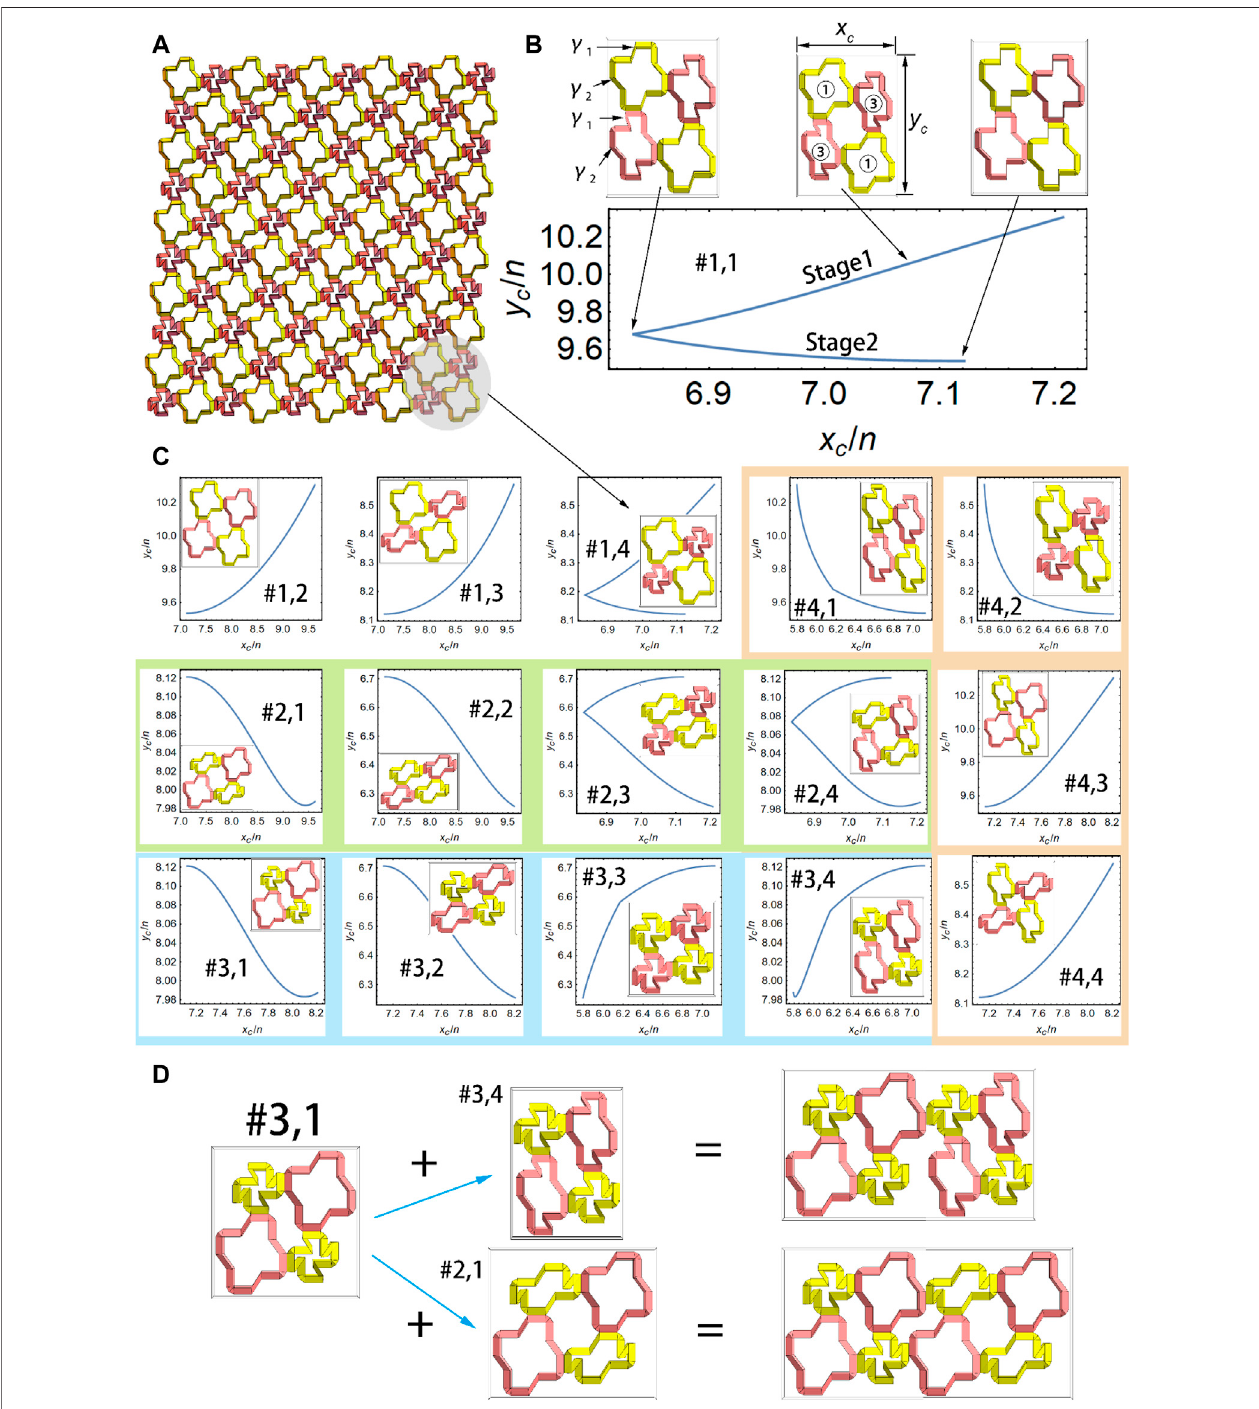
FIGURE5| Multiple deformation patterns of 2D cellular structures. (A) 2D cellular structures comprising 5 × 5four-unit combinations. (B) One deformation pattern of a four-unit combination comprising four ring-like units. (C) Other 15 deformation patterns of the four-unit combination. Each deformation pattern is represented by a x c / n − y c / n curve. For all units, the value of θ 1 is the same, and 0 ≤ θ 1 ≤ 180 ° . The 16 patterns can be divided into four groups, shown against white (group #1), green (group #2), blue (group #3), and orange (group #4) backgrounds. (D) Combination within a group: #3.1 and #3.4; combination across groups: #3.1 and